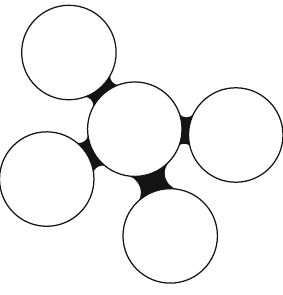
Figure 1: Liquid bridges between wet granular coal